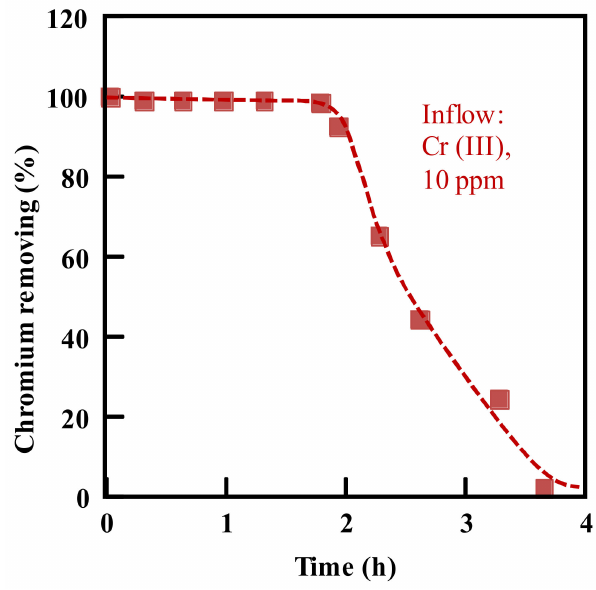
Figure 8. Chromium removing by the amidoxime adsorbent in the column mode adsorption at pH 5.0. Density of functional groups, 4.53 mmol/g; inflow solution, 10 ppm for the Cr(III); flow rate, 60 mL/h; room